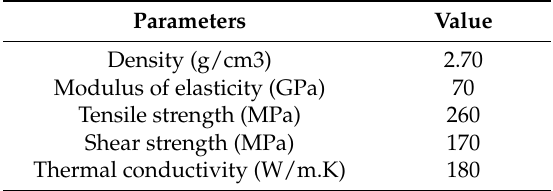
Table 1. Mechanical properties of the sample material